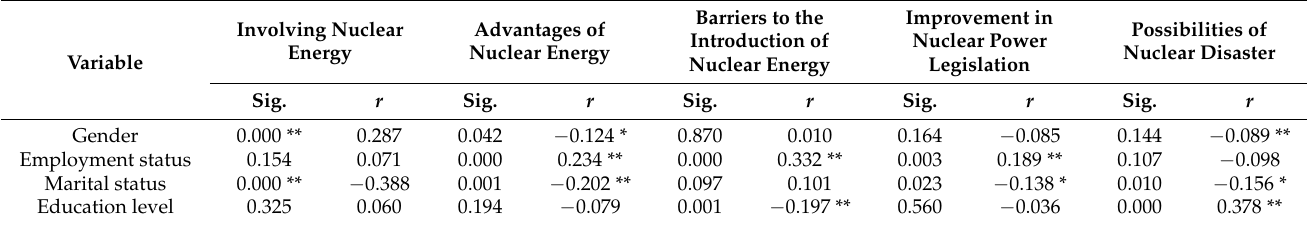
Table 4. Pearson’s correlation results between the perception of public nuclear energy and predictor variables. Barriers to the Improvement in Involving Nuclear Advantages of Introduction of Nuclear Power Energy Nuclear Energy Variable